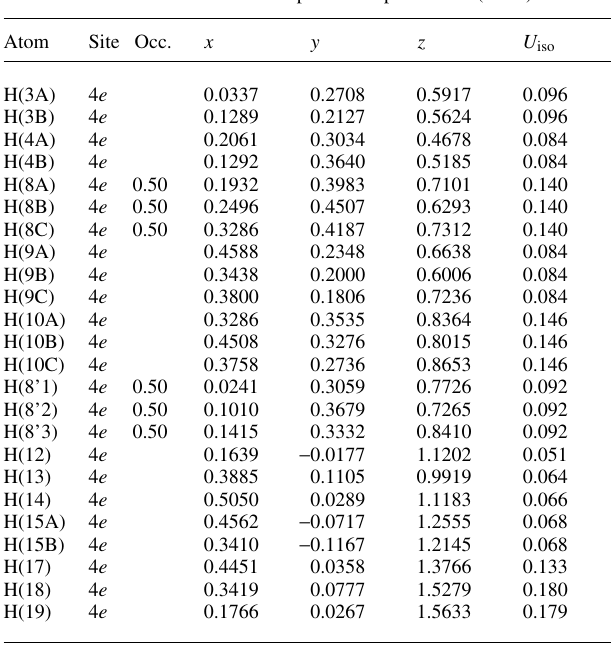
Table 2. Atomic coordinates and displacement parameters (in Å 2 )